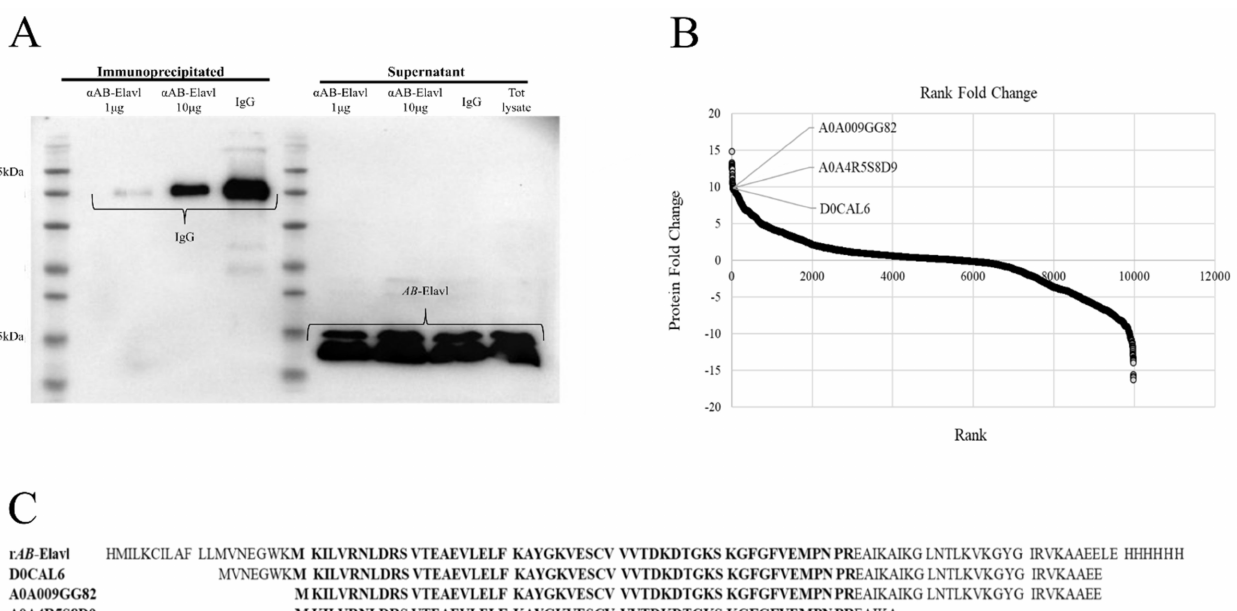
Figure 3. Molecular characterization of AB-Elavl. ( A ) Immunoprecipitation assay on the total protein lysate of A. baumannii. IgG was used as a control. No enrichment of the protein was visible by western blot analysis. ( B ) Protein ranking based on log 2 fold-changes (IP/IgG) for all the proteins identified by MS showing an enrichment of three hypothetical and highly similar RNA-binding proteins (RBPs) in the top ten proteins. ( C ) Entry code and amino acid sequence of the three hypothetical RBPs based on the IP-MS analysis compared with the rAB-Elavl sequence. Bold retrieved peptides (sequence